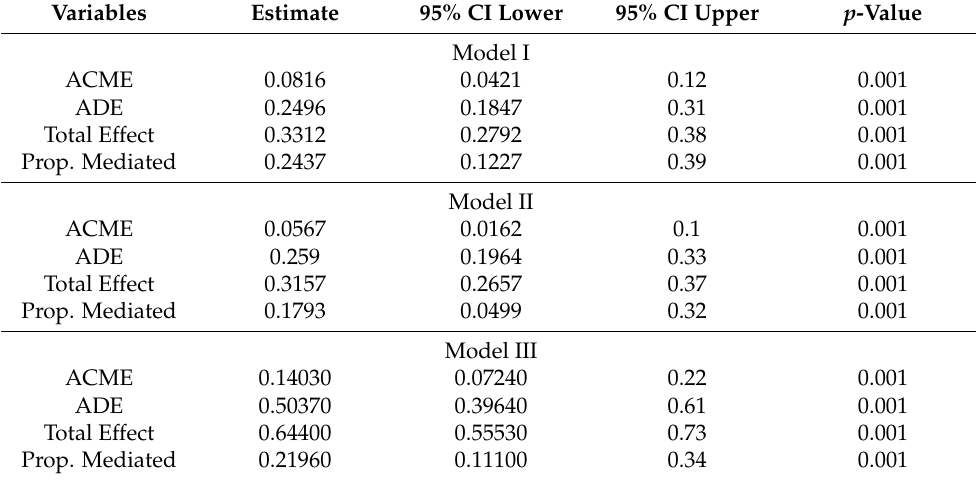
Table 4. Direct, indirect and total effect for mediation models. Model 1 depression as dependent variable, model II anxiety as dependent variable and model III psychological distress as dependent variable. Bootstrap CI